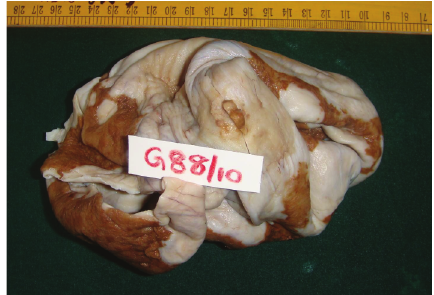
Figure 1: Ovarian tumor with mural nodule.